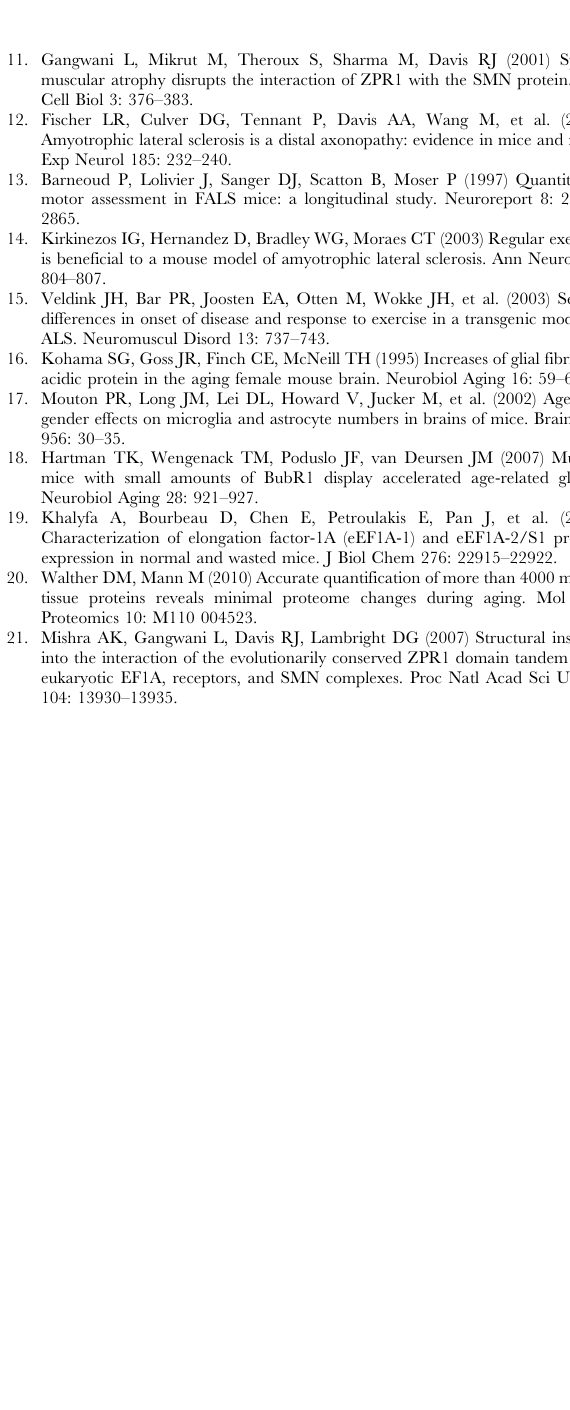
Figure S1 Higher resolution images of GFAP and NF-H staining in aged heterozygous and wild-type